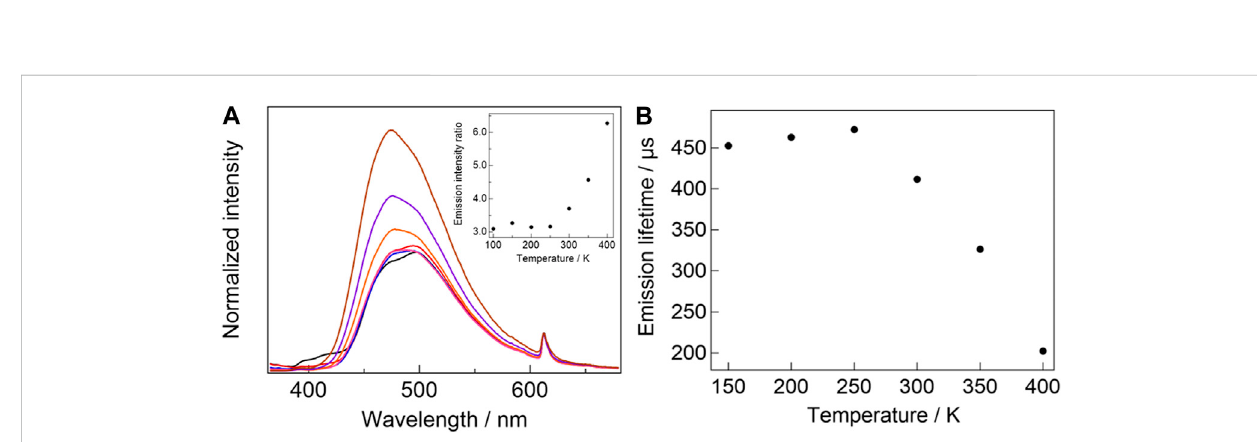
FIGURE 5 (A) Temperature-dependentemission spectraof[Eu 2 (hfa) 6 (PDDPO) 2 ](blackline:100K,redline:150K,blueline:200K,pinkline:250K,orangeline: 300 K, purple line: 350 K, brown line: 400 K, λ ex = 300 nm). Inset: temperature-dependent emission intensity ratio of pyrene excimer to Eu(III). (B) Temperature-dependent emission lifetime of [Eu 2 (hfa) 6 (PDDPO) 2